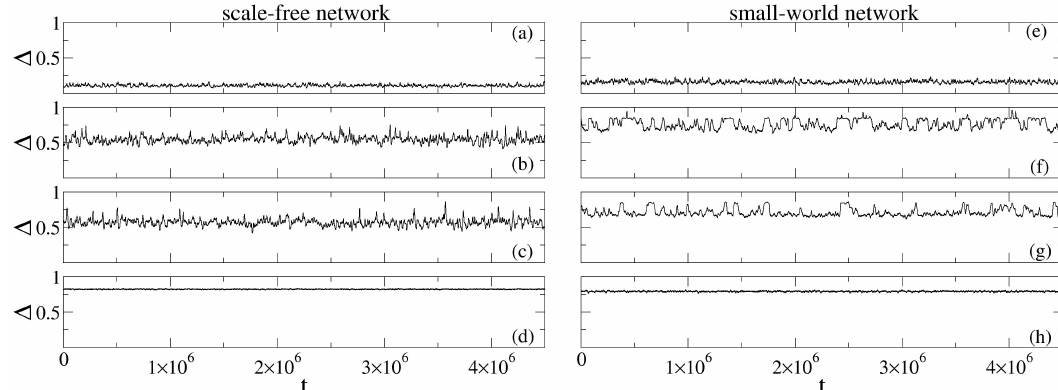
Figure 8. Examples of the determinism time series ( ∆ ) evaluated from the mean field of the network for the scale-free network (panels ( a ), ( b ), ( c ), and ( d )) and the small-world network (panels ( e ), ( f ), ( g ), and ( h )). Here, panels ( a ) and ( c ) are representative of unsynchronized states ( ε = 0.002), and panels ( b ), ( c ), ( f ), and ( g ) are representative of states at the transition region ( ε = 0.0045, ε = 0.0050, ε = 0.0105 and ε = 0.011, respectively). At the transition region, it is observed that the system assumes different states of synchronization (different values of ∆ ).